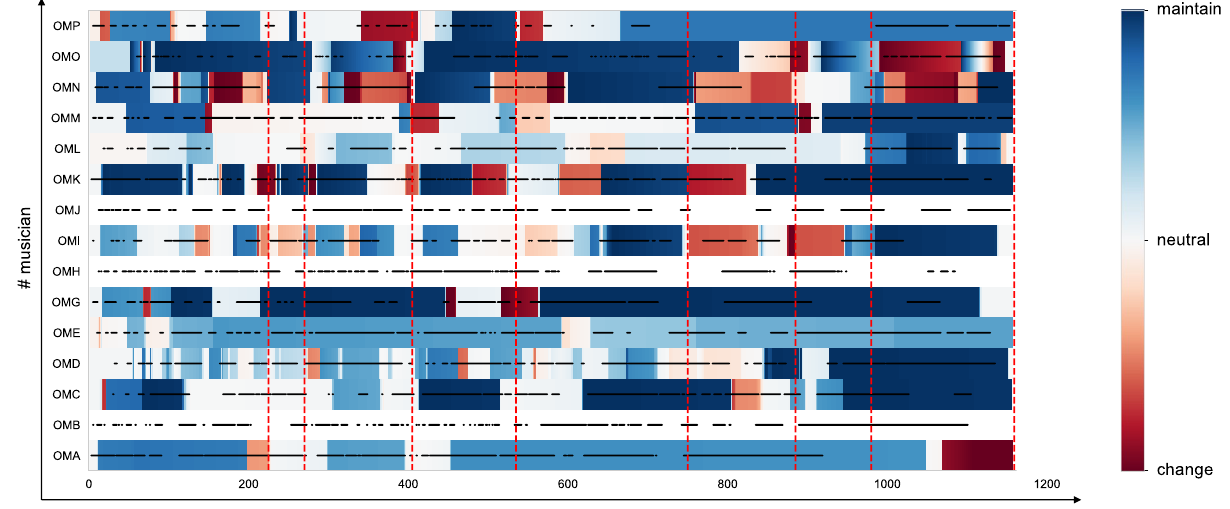
Figure 2. Raw data. The y-axis corresponds to individual musicians, and the x-axis represents time in seconds. Colors show musicians’ reports about their directional intentions upon re-listening to the performance following the collective improvisation. Black horizontal lines show the musical actions of each musicians. Red vertical dotted lines show the boundaries of the musical sequences identified by the expert annotator. Data for the directional intentions of OMB, OMJ and OMH are missing due to a technical